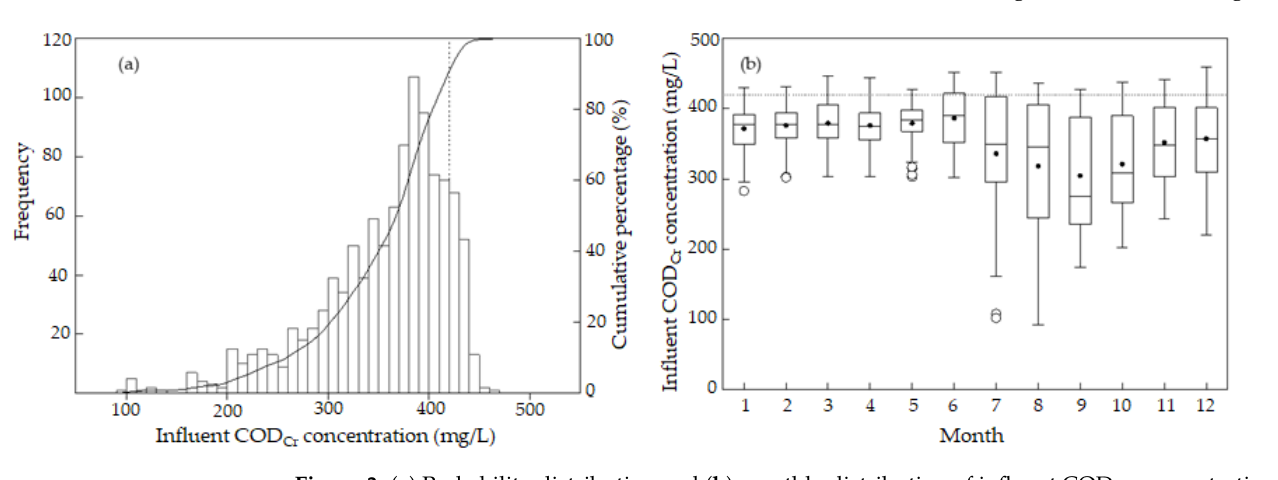
Figure 3. ( a ) Probability distribution and ( b ) monthly distribution of influent COD Cr concentration. The solid circle (•) represents the average. Outliers are marked by a hollow point (°).